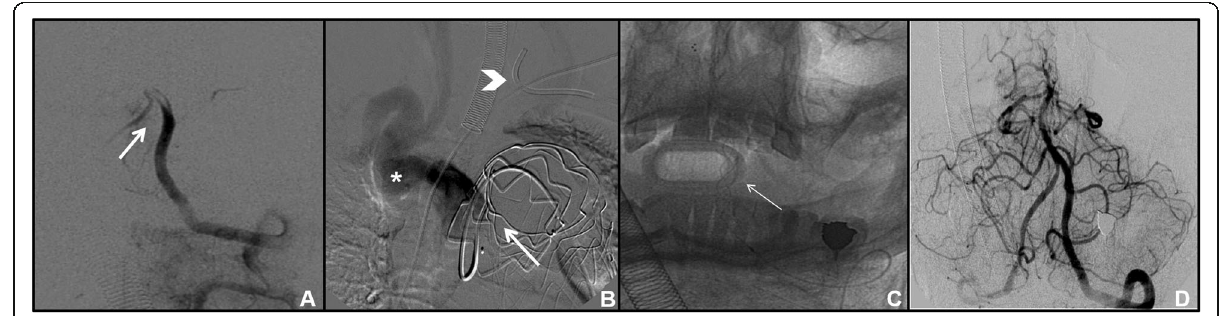
Fig. 5 Left TRA in a 64-year-old woman with AIS of left vertebro-basilar segment (arrow in a ). After left VA catheterization with a 6-F guiding catheter (arrowhead in b ), additional femoral approach for right procedural checks was not achieved (arrow in b ) because of marked brachiocephalic tortuosity (asterisk in b ) and aortic endoprosthesis. After a first-pass mechanical thrombectomy with stent retriever (arrow in c ) a TICI 3 was obtained ( d